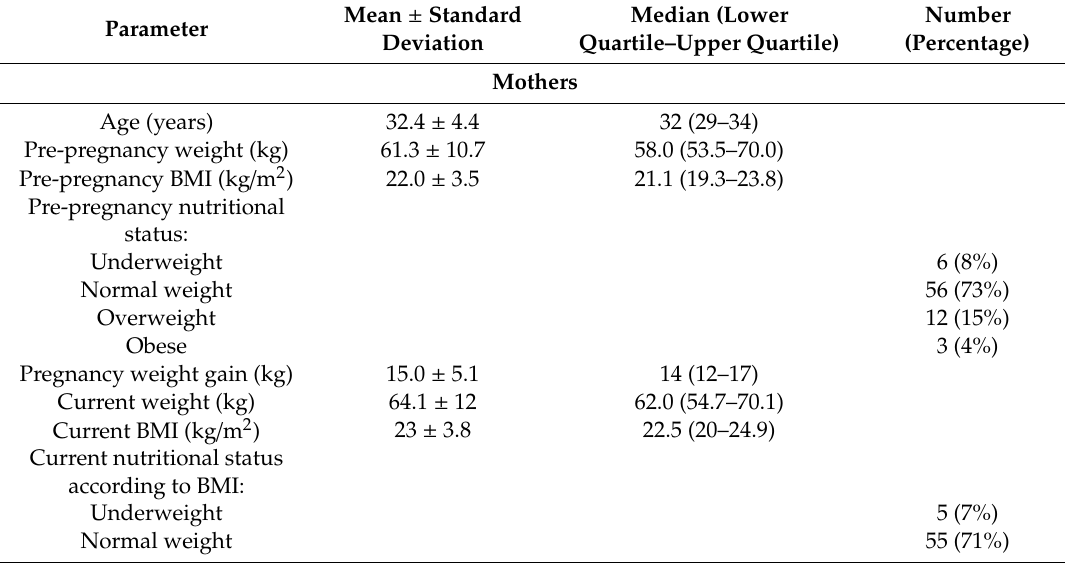
Table 1. General characteristics of the study group ( n =